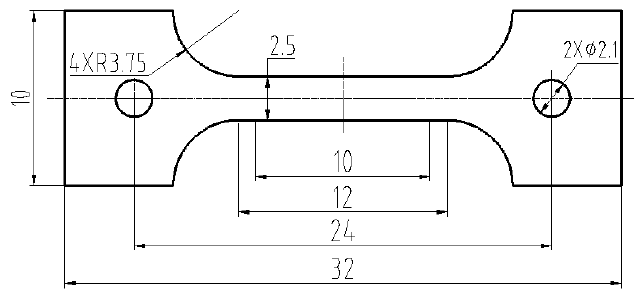
Figure 2. Schematic of geometrical dimensions of tensile specimens.